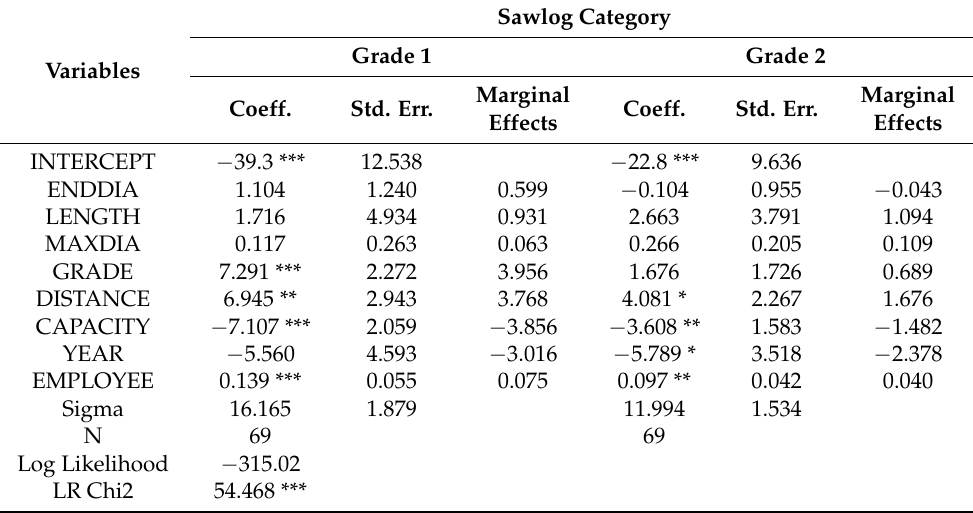
Table 3. Results of a tobit regression model used to estimate a price premium for Grade 1 and Grade 2 sawlogs above the current stumpage price, grown to an extended rotation across the southeastern United States based on a 2018 mail survey.